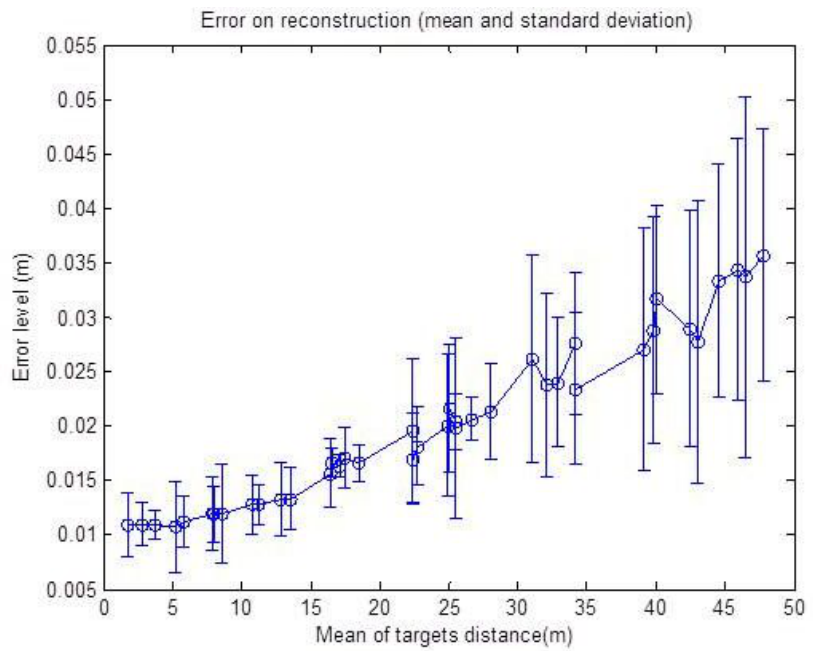
Figure 16. Reconstruction error with respect to the mean depth of the targets with a noise level corresponding to ± 2 p, ± 2 ◦ for α and ± 2 cm for r . The error is in meters. The mean and standard deviation of the RMSE, over 50 reconstructed points, are